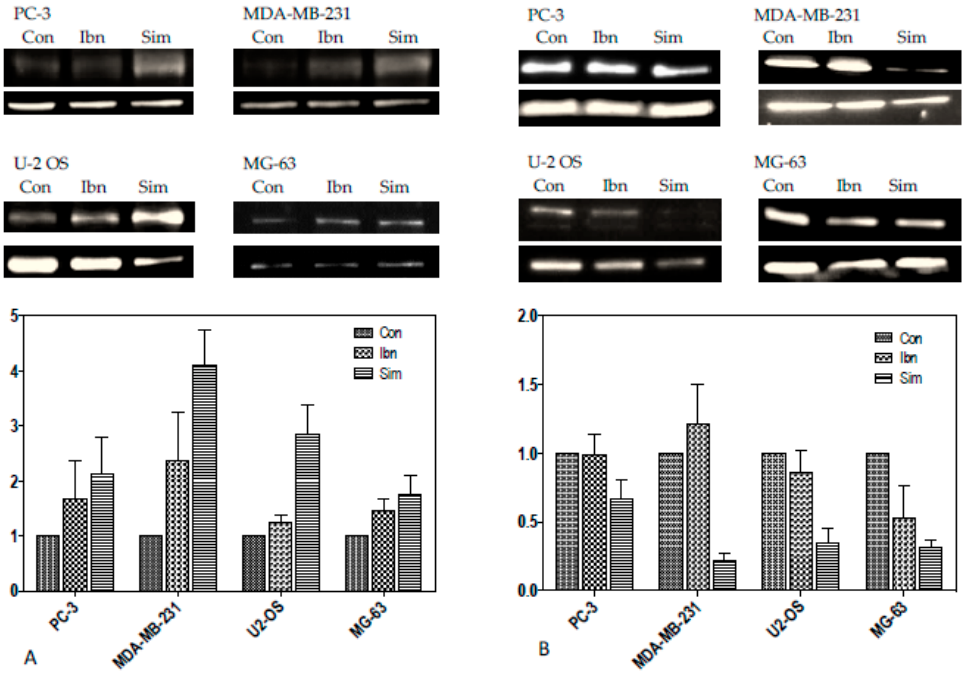
Figure 4. Effect of ibandronate (Ibn) and simvastatin (Sim) on the mRNA expression of the histone demethylase KDM7A . Bars represent the mean ± SD; * p ≤ 0.05, ** p ≤ 0.01, Control (Co) vs. treatment. † p ≤ 0.05, ibandronate vs. simvastatin; n = 3.